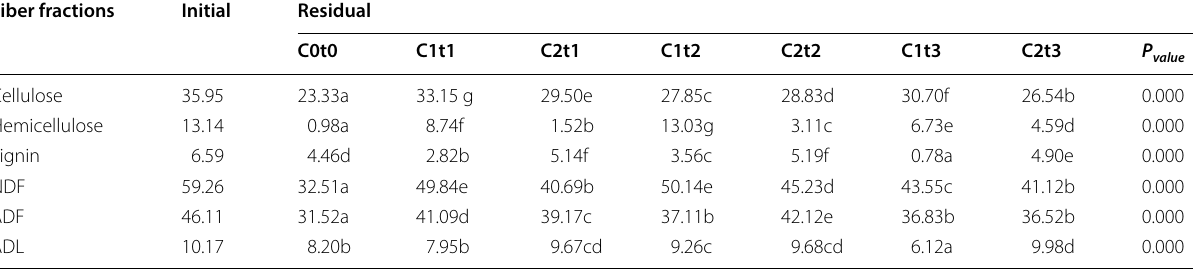
Values are means; means within the same row followed by the same letters are not significantly different at P < 0.05 according to Duncan’s multiple range test, NDF: neutral detergent fiber, ADF: acid detergent fiber, ADL: acid detergent lignin